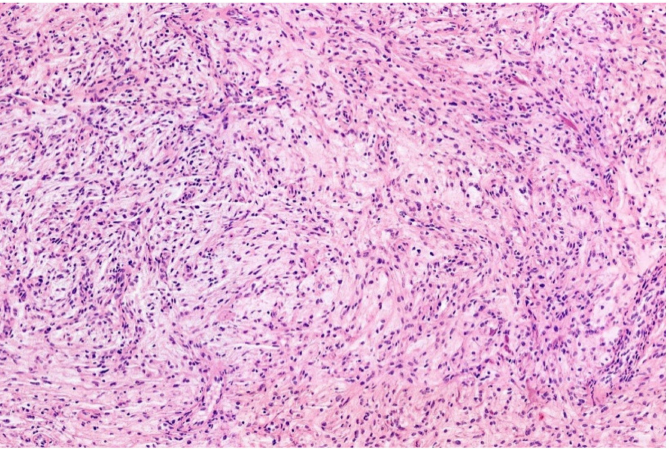
Figure 7. Primary pulmonary myxoid sarcoma: relatively uniform spindle cells arranged in loose fascicles in a myxoid matrix (HE; 20 × magnification).